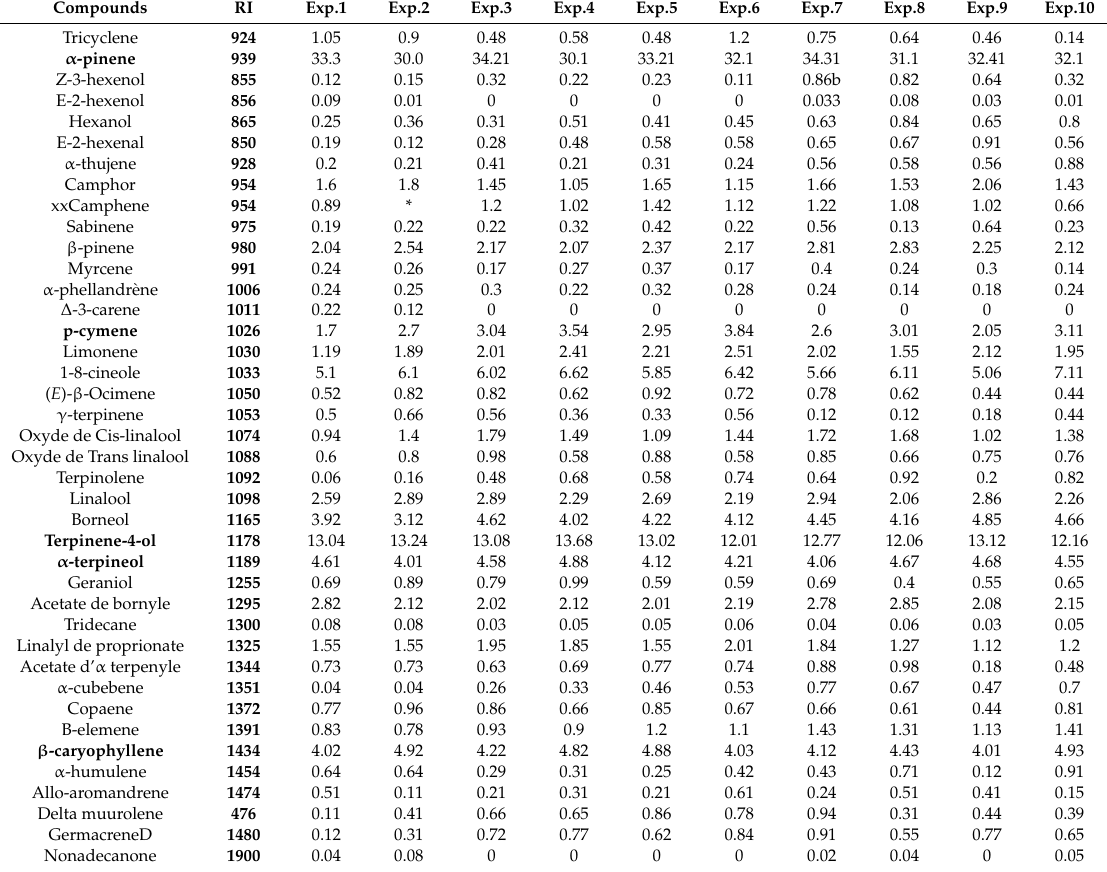
Table A1. Percentages areas of compounds found in the oils obtained by SFE from leaves in each experiment. Compounds RI